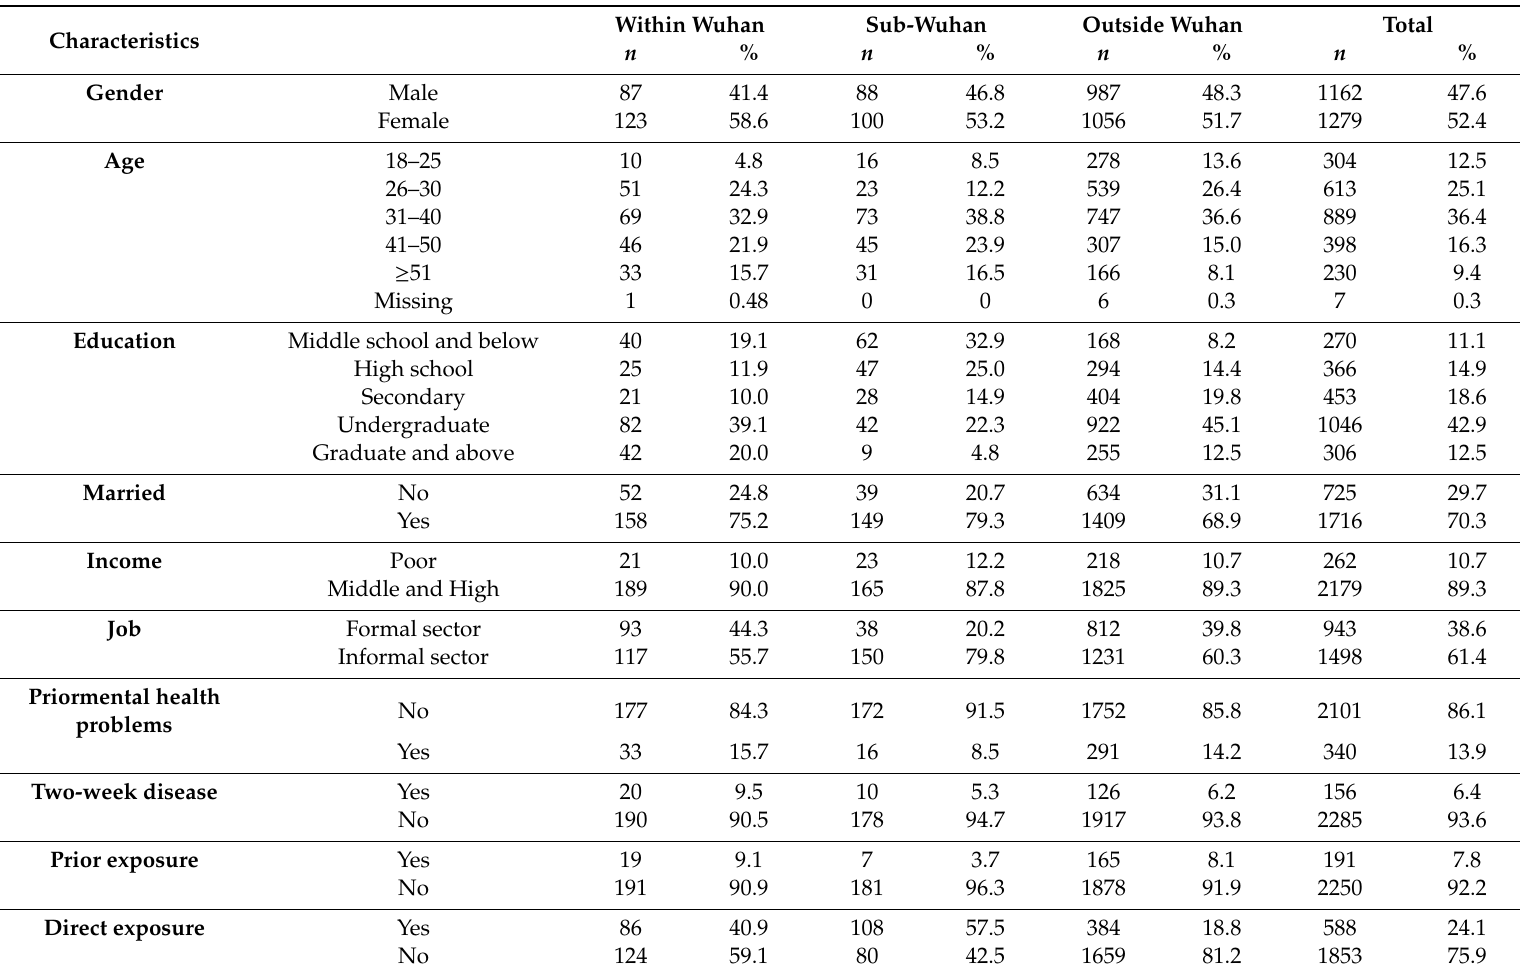
Table 1. Descriptive data on social-demographics, exposure, and coping style in the current sample ( N = 2441).